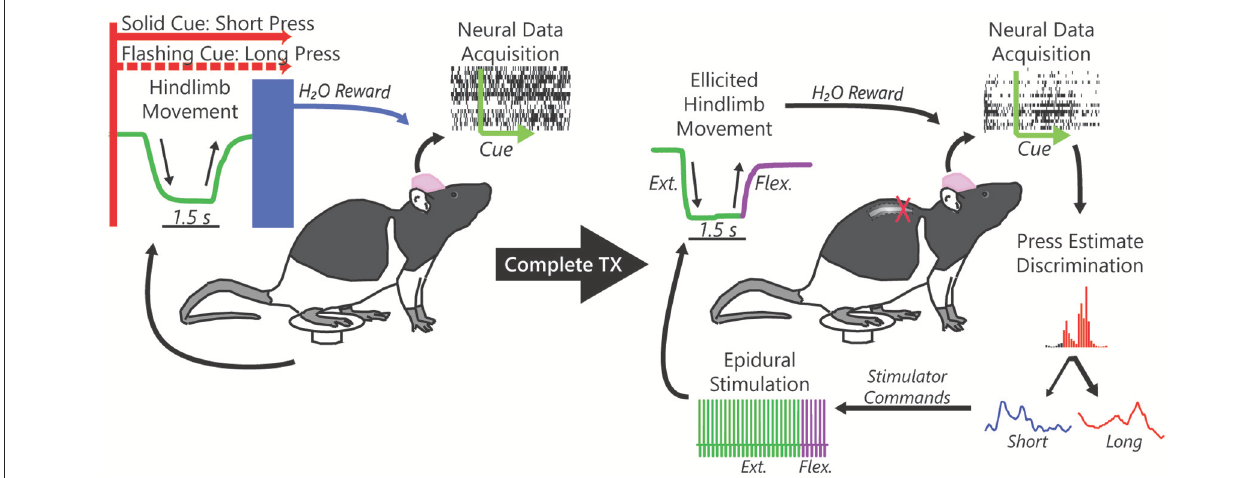
FIGURE 1 | Single neuron action potentials (spikes) were recorded from populations of neurons within the rat hindlimb sensorimotor cortex while rats performed a cued hindlimb press task for a water reward. Using the acquired spikes, we formulated an online algorithm to replace the pressing behavior with neural control of the water reward. We then subjected rats to a complete midthoracic spinal cord injury (complete TX) that left the hindlimbs completely paralyzed and, after reintroduction to the task, used task-related neural activity to decode intention to press (short or long duration) in response to the cue and subsequently to control implanted epidural electrical stimulation electrodes implanted over the intact lumbar spinal cord to restore the task-dependent hindlimb movements.